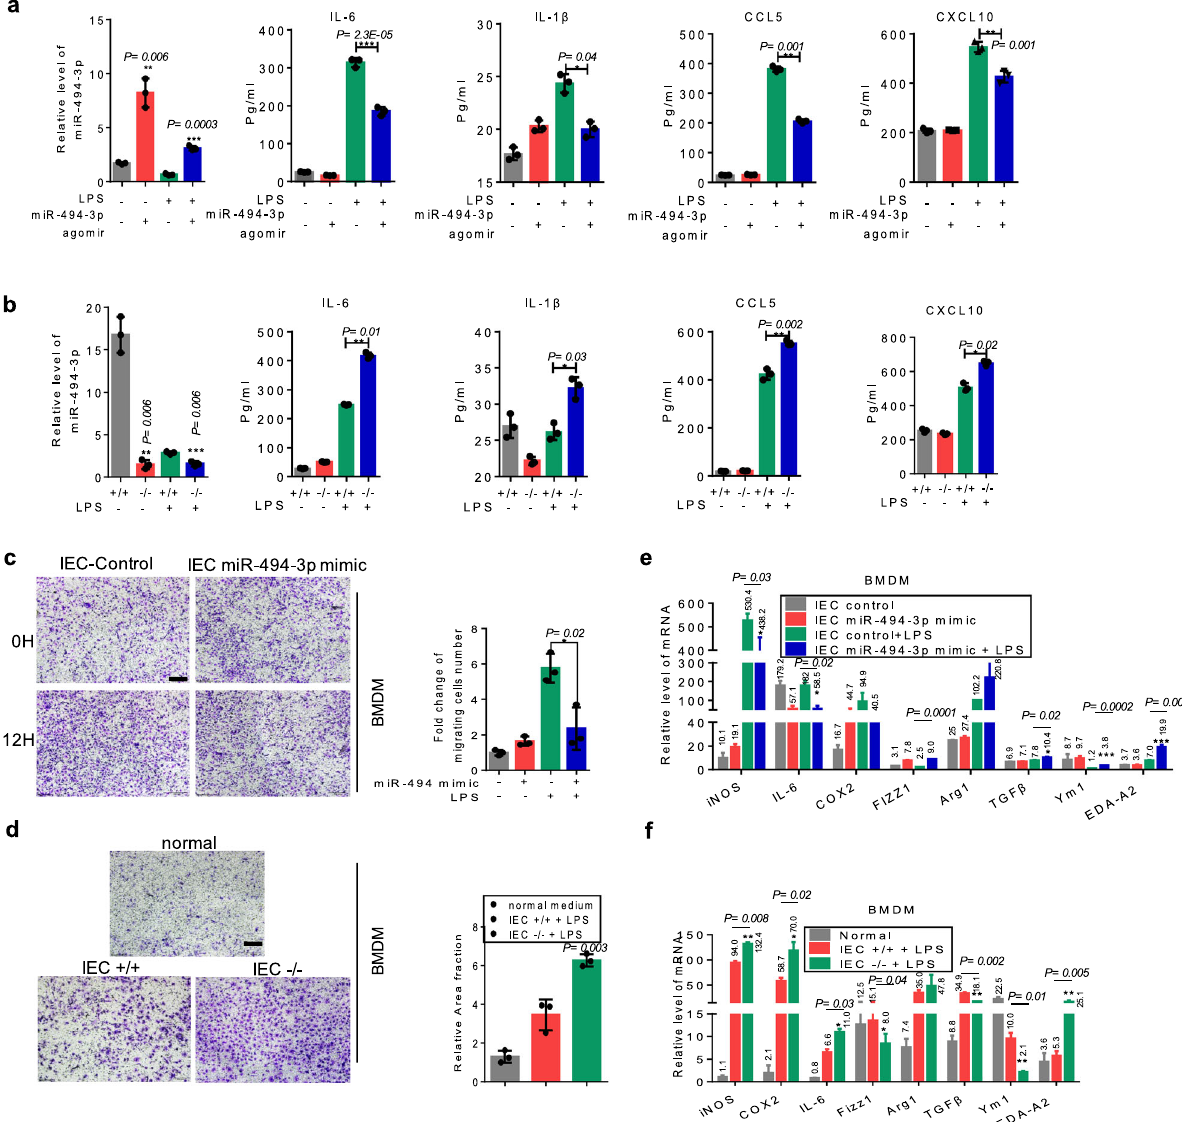
Fig. 5 Depletion of miR-494-3p in differentiated IECs promotes macrophage recruitment and M1 polarization in colitis. a , b The protein levels of each indicated cytokines and chemokines were determined by ELISA in the supernatants of IECs (from WT mice) with or without LPS treatment following control mimic or miR-494 mimic transfection ( a ) or of IECs from miR-494 − / − mice and WT mice treated with or without LPS ( b ). The levels of miR-494- 3p were measured by qRT-PCR (normalized by U6). c , d Representative images and quanti fi cation of the fold change of migrating BMDMs following incubation with CM from indicated IECs that had been transfected with control mimic or miR-494-3p mimic for 24 h ( c ) or from IECs extracted from miR- 494 − / − mice or WT mice ( d ). Scale bar: 200 μ m. e, f The mRNA levels of M1 and M2 markers were measured by qRT-PCR analysis in BMDMs incubated with CM from IECs with indicated treatment ( e ) or incubated with CM from indicated IECs from miR-494 − / − mice or WT mice ( f ). Except as indicated, all qRT-PCR values were normalized against the expression of the transcript encoding β -actin . Data are presented as mean ± S.D. and analyzed by non-paired two-tailed Student ’ s t- test in the graphs in ( a – f ). *** P ≤ 0.001, ** P ≤ 0.01, * P ≤